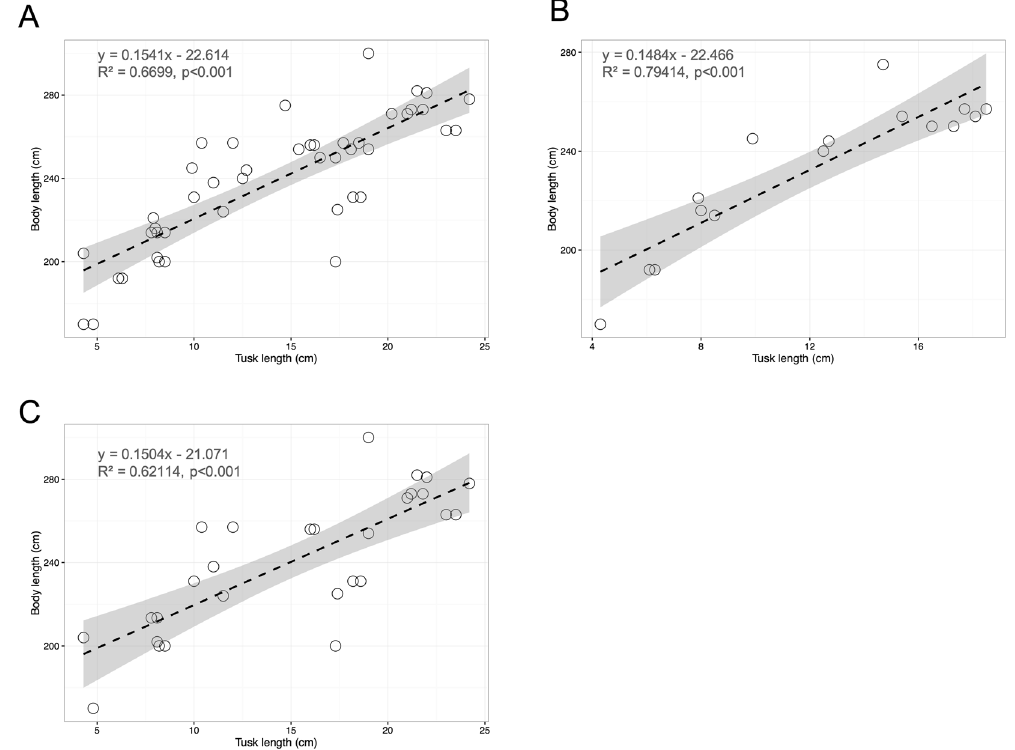
Figure 8. The relationship of dugong tusk length (cm) and body length (cm) for both sexes ( A ), only males ( B ) and only females ( C ). The dashed line is the regression line of each equation with 95% confidence interval. Tusk length was compared between sexes, and no significant difference was found (p =